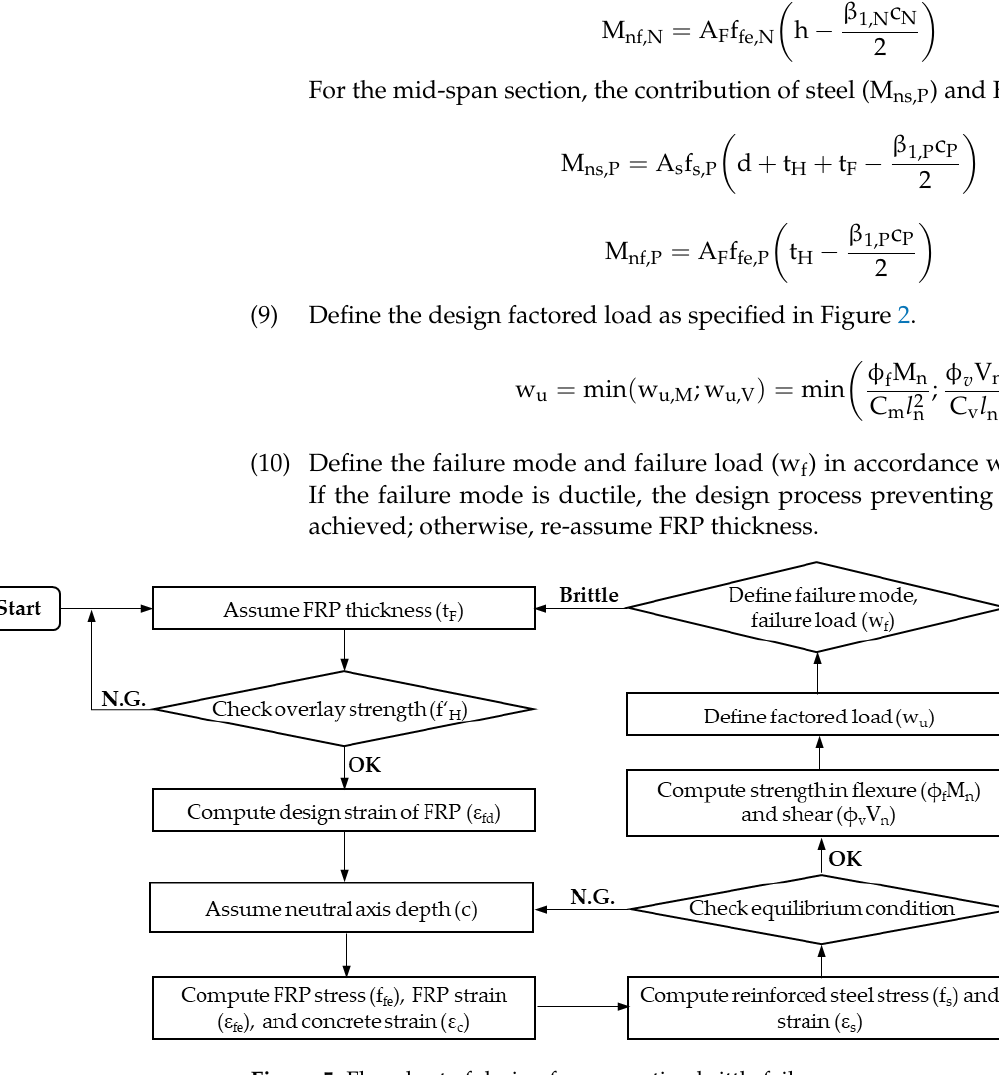
Figure 5. Flowchart of design for preventing brittle